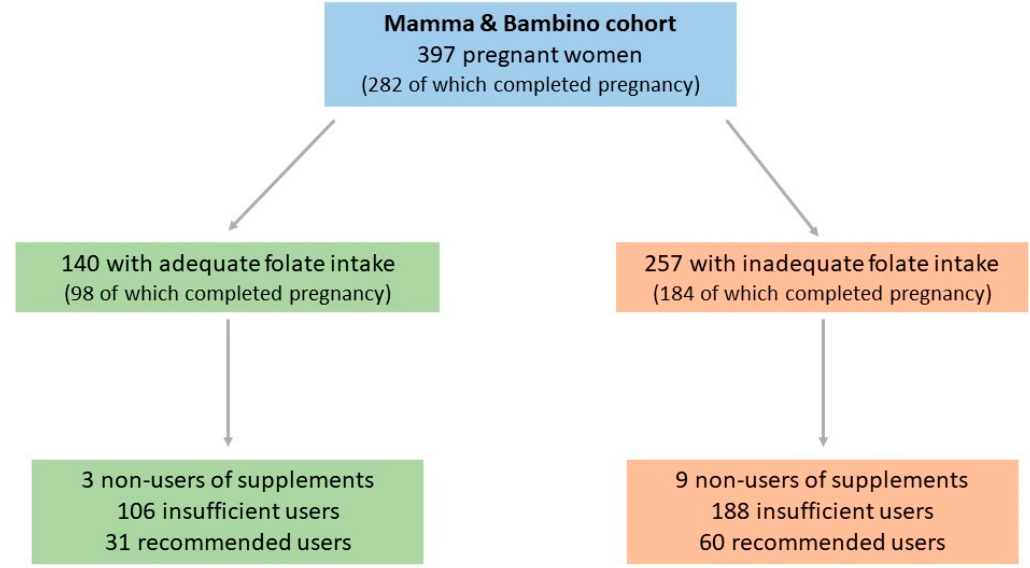
Figure 1. The distribution of women according to dietary folate intake and use of supplements.